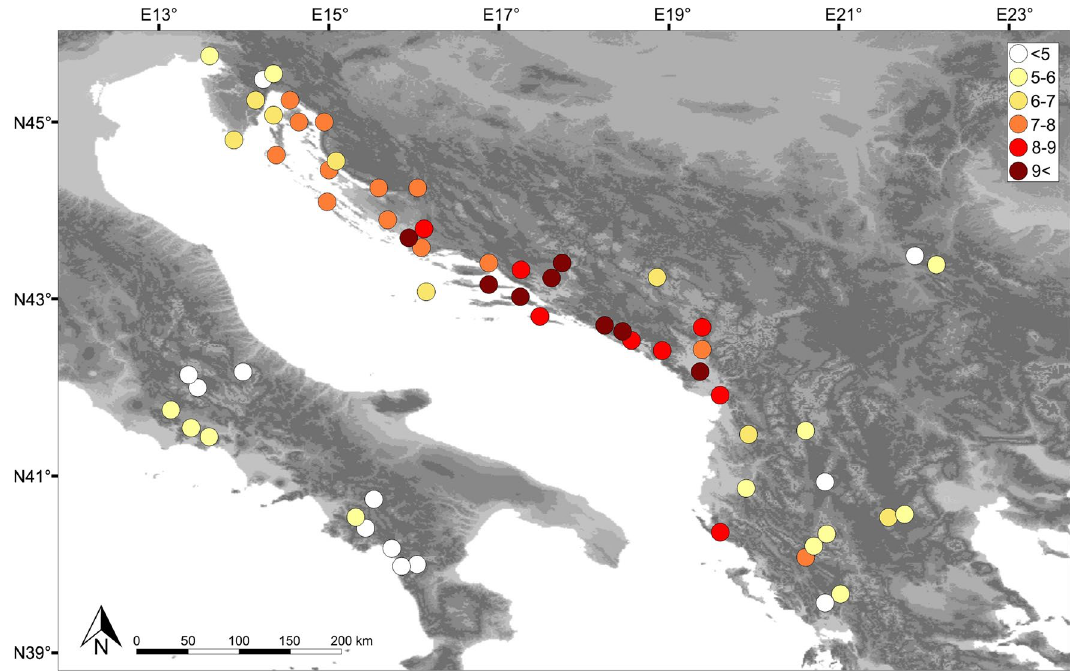
Figure 1. Distribution of allelic richness among the studied common sage ( Salvia officinalis L. ) populations as revealed by microsatellite markers. Coloured dots represent analysed populations of S. officinalis . Colours, from white to dark red, indicate allelic richness levels for individual populations. Allelic richness values for each colour are presented in the upper-right corner. The satellite imagery was obtained from Natural Earth public domain map dataset (https:// www. natur alear thdata. com/ downl oads/ 10m- raster- data/ 10m- gray- earth/). CorelDraw Graphics Suite X7 Version 17.1.0.572 (Corel Corp., Ottawa, Canada) was used to create the